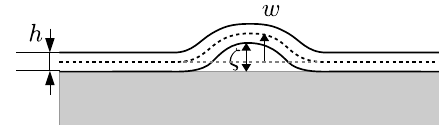
Figure 5. Schematic of a thin film on a substrate. The thickness of film is h . The mid-plane displacement and the distance between the substrate and film are denoted by w and ζ ,